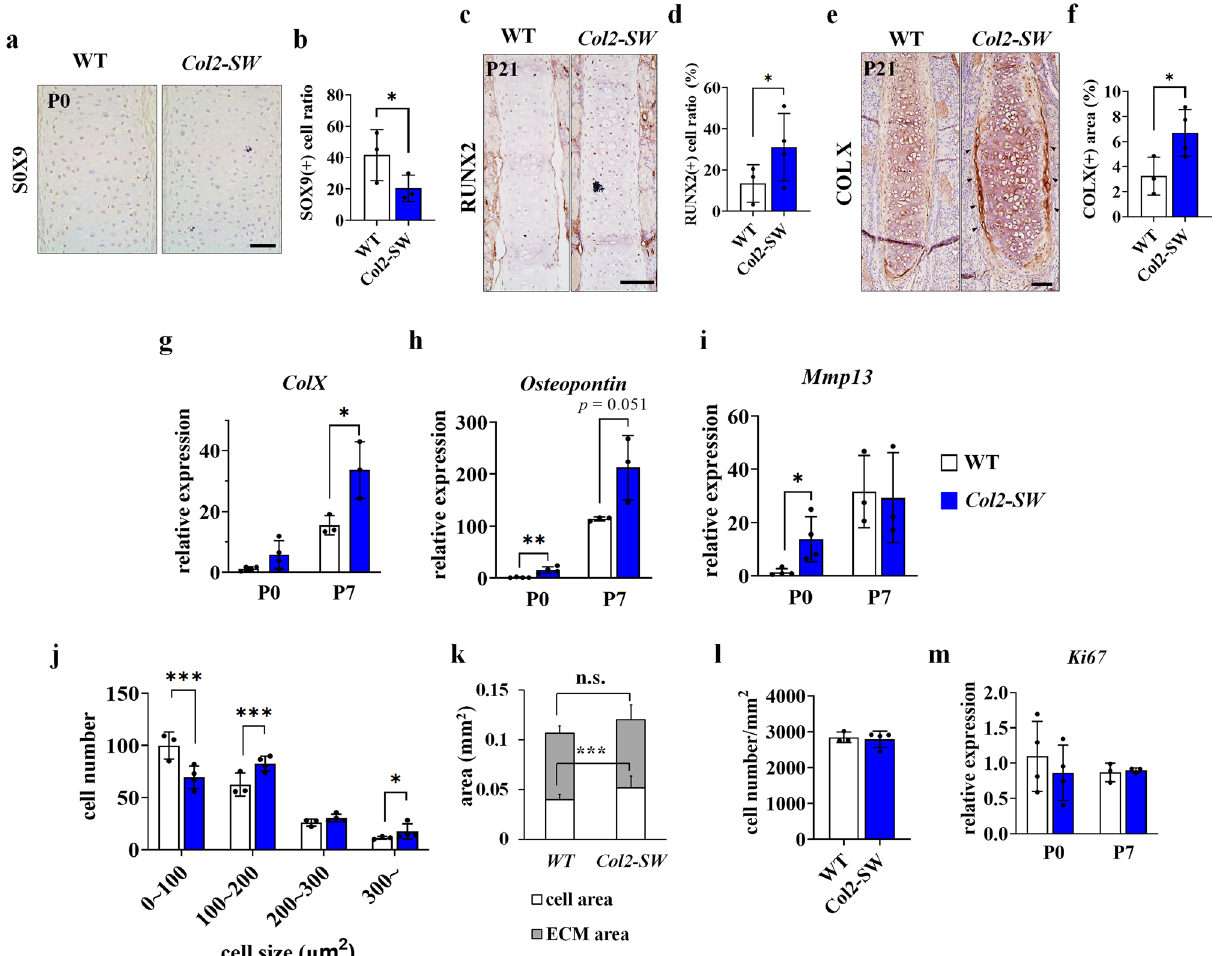
Figure 5. Increased chondrocyte hypertrophy and cellular size, which induced thickening of the nasal septal cartilage. ( a , b ) Immunohistochemistry of SOX9 and SOX9-positive cell ratio in the septal cartilage at P0. Scale bar: 50 µm. Three mice per genotype were used. ( c , d ) Immunohistochemistry of RUNX2 and RUNX2- positive cell ratio in the septal cartilage of mice at P21. Scale bar: 100 µm. ( e , f ). Immunohistochemistry of type X collagen (COLX) and COLX-positive area ratio in the septal cartilage of mice at P21. Positive cell and area ratio from randomly selected three slides from each mouse was averaged. The black arrowheads indicate the expression of COL X at the edge of the septal cartilage of Col2-SW . Scale bar: 100 µm. For RUNX2 and COLX positive cell or area measurements, three WT mice and four Col2-SW mice were used. Three slides were randomly selected from each mouse. Gene expression of markers of chondrocyte hypertrophy: Col10a1 ( g ), Osteopontin ( h ), and matrix metalloproteinase-13 ( Mmp13 ) ( i ) in the septal cartilage at P0 and P7. The expression level was normalized to Gapdh . RNA from P0 mice (n = 4 per genotype) and P7 mice (n = 3 per genotype) were used. ( j ) Septal chondrocyte size distribution in the septal cartilage at P21. ( k ) The extracellular matrix (ECM) (gray) and cellular (white) area in the septal cartilage at P21. The difference of ECM area between two groups was not significant. ( l ) The cell density (cell number/area) was measured in the septal cartilage at P21. For histological assessments ( j – l ), three WT mice and four Col2-SW mice were used. Four slides were randomly selected from each mouse. ( m ) Gene expression of Ki-67 in the septal cartilage at P0 and P7. Values are presented as means ± standard deviations. For Student’s t test, * p ≤ 0.05, ** p ≤ 0.01, *** p ≤ 0.001. n.s., not